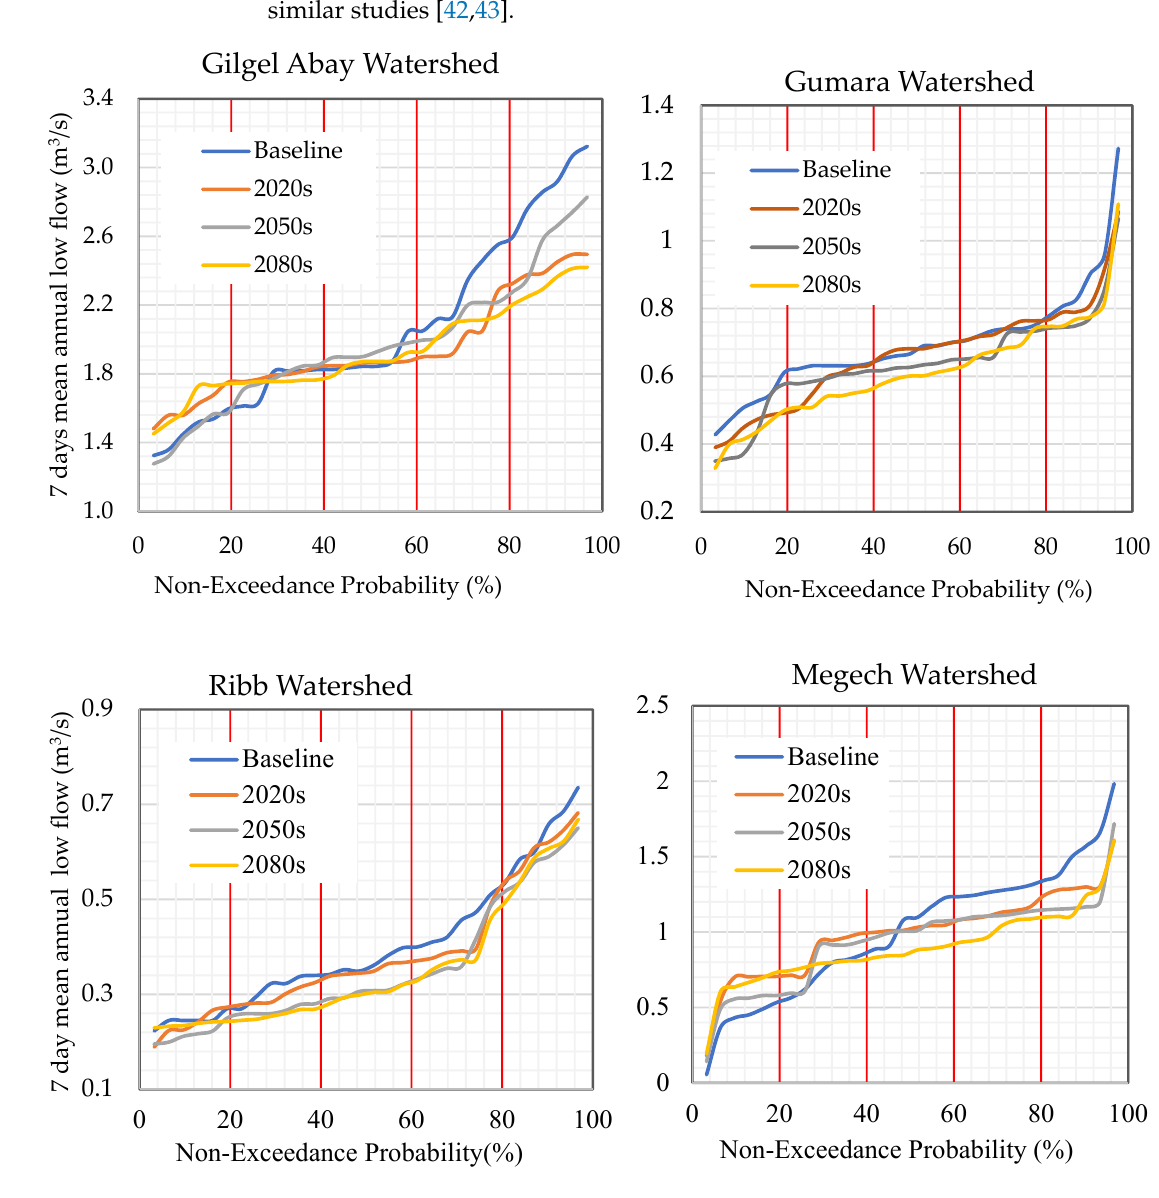
Figure 5. Flow Duration Curve of low flows of watersheds.